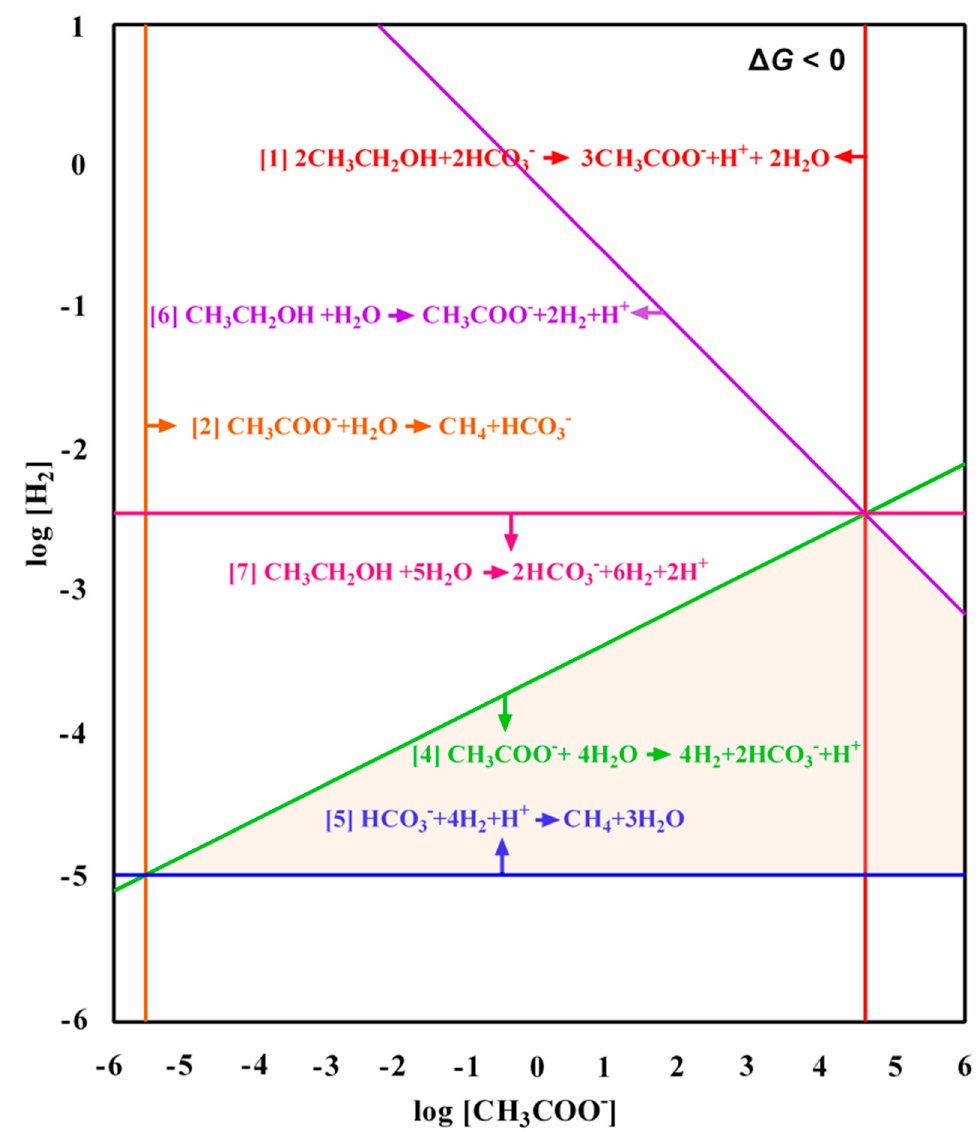
Figure 5. The opportunity window of thermodynamics for different metabolic pathways involved in methane production from ethanol with concentrations of acetate and hydrogen as thermodynamic constraints. The orange area represents route 4, containing reactions 6, 4, and 5, i.e., the bioconversion of ethanol to acetate and hydrogen, linked with syntrophic acetate oxidation and hydrogenotrophic methanogenesis.